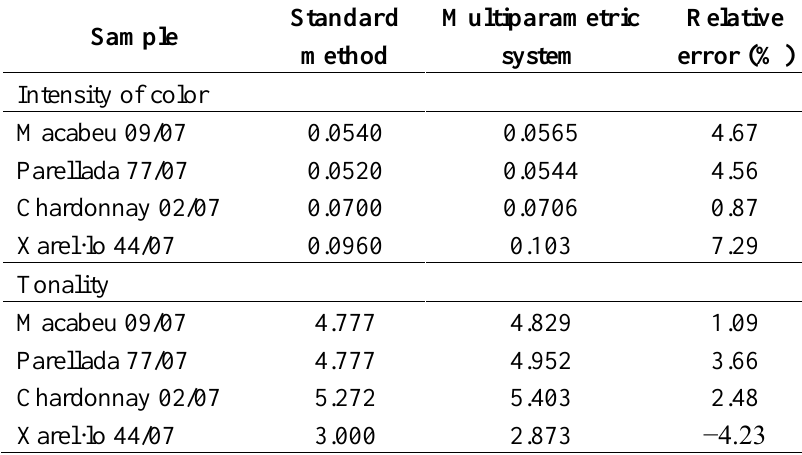
Table 3. Quantification with PLS technique of some optical parameters of white wine samples with the system. Standard method’s data were provided by INCAVI and